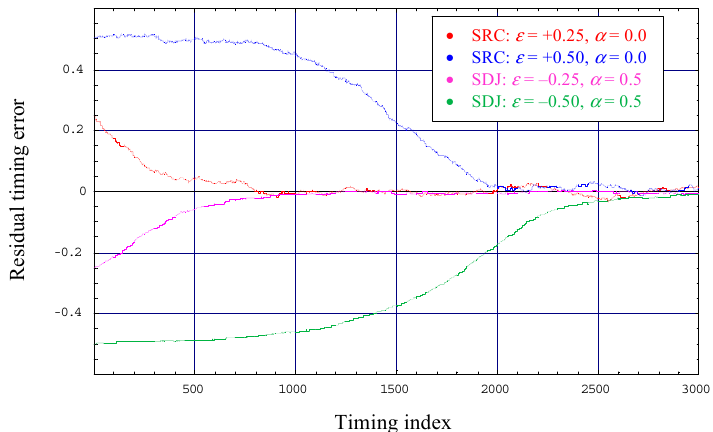
Figure 7. Timing trajectories for dual-filter solutions (4-PAM, γ s = 15 dB, B L T e = 10 − 3 ).